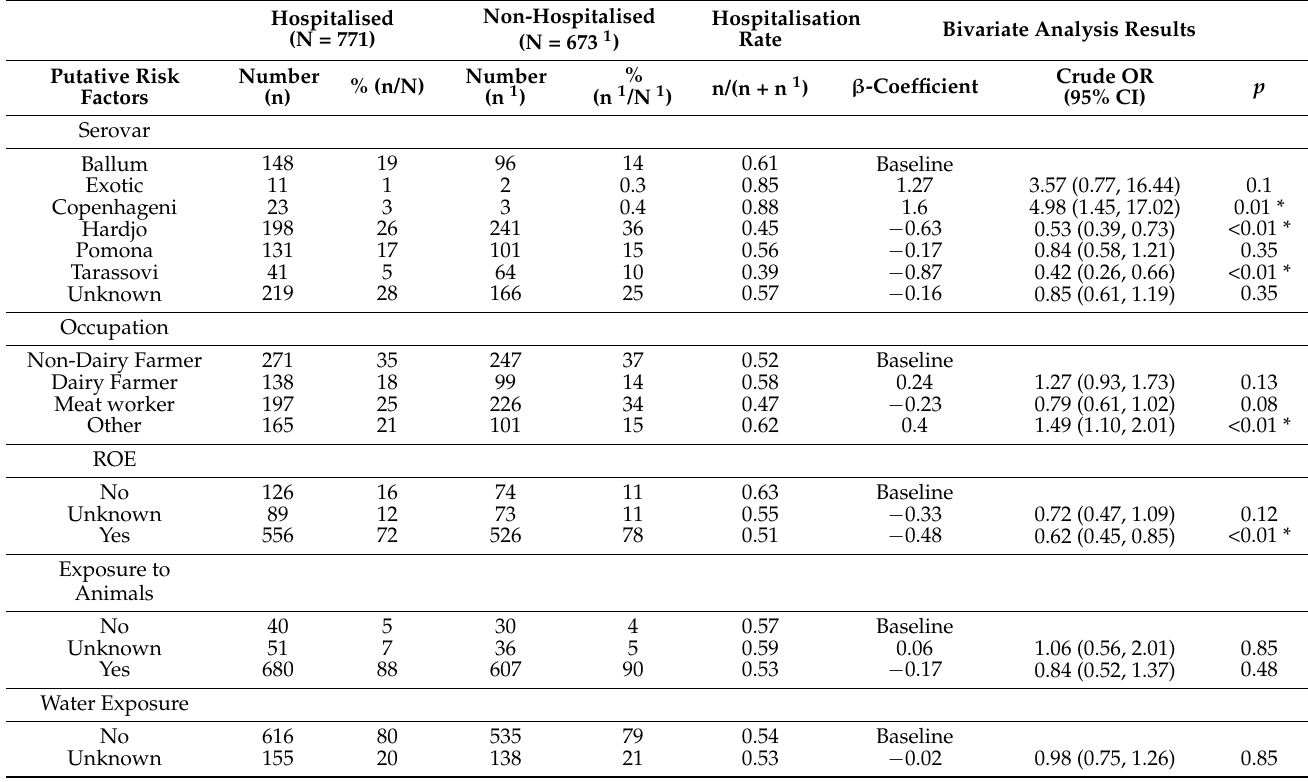
Table 2. Putative risk factors and crude odds ratios for hospitalisation amongst notified cases of leptospirosis in New Zealand 1999–2017.